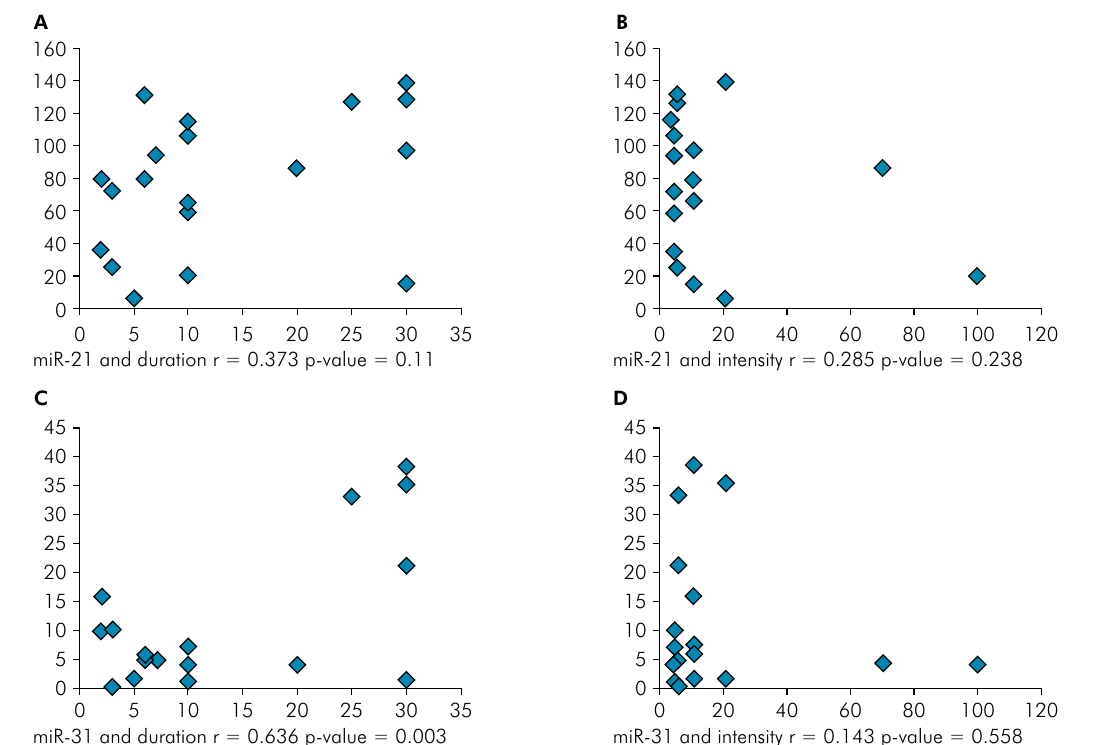
Figure 3. Correlation between tobacco smoking intensity and duration with fold difference of miRNA-21 and miRNA-31.